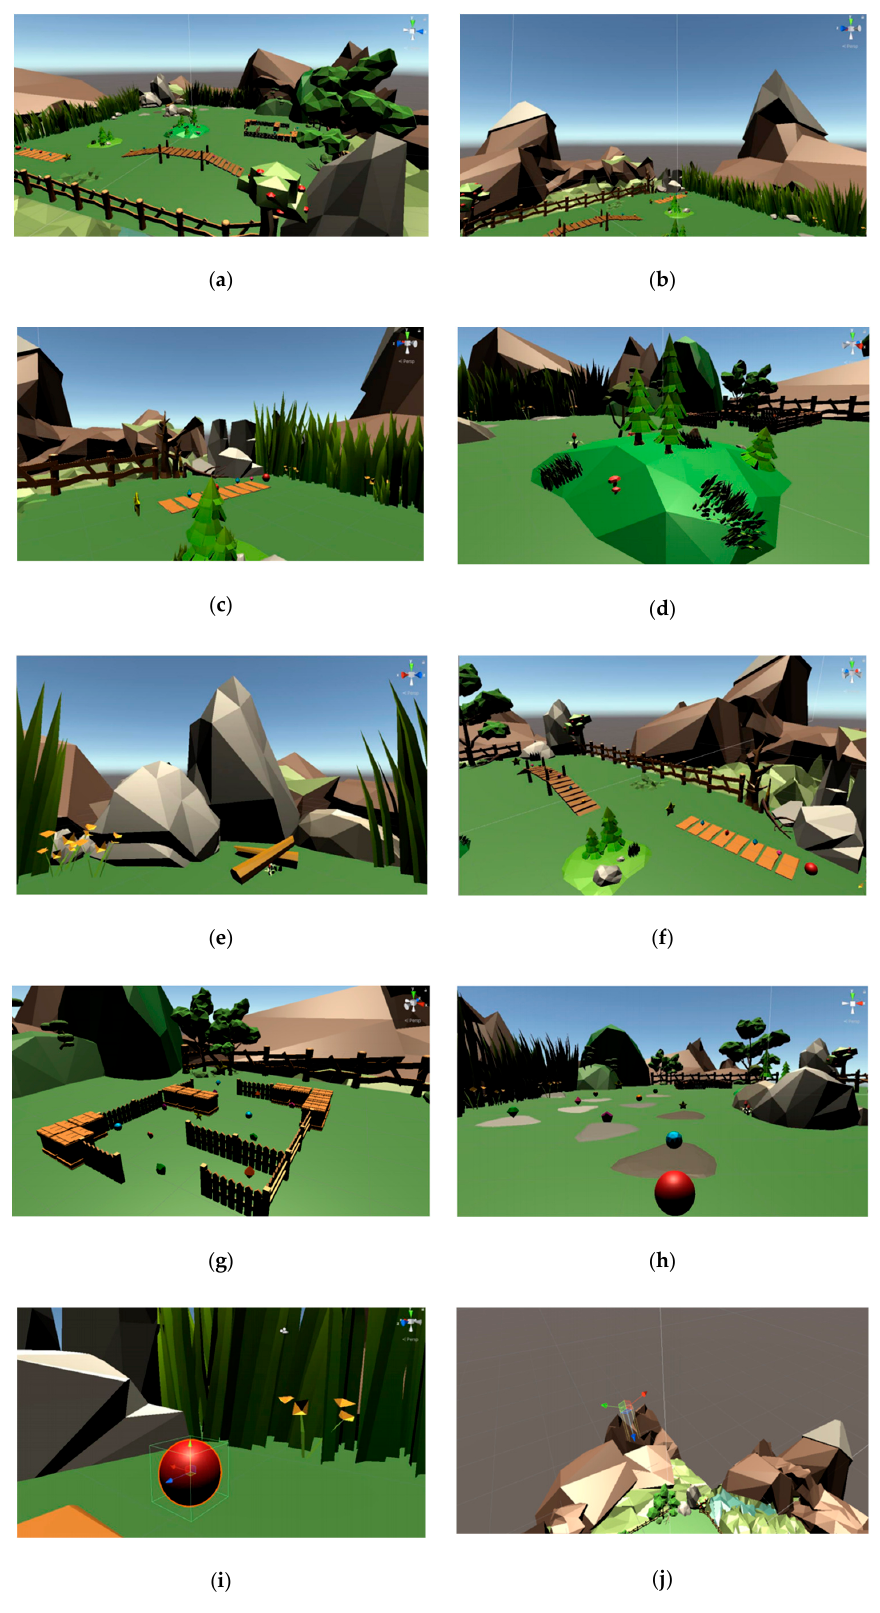
Figure 2. Game views: ( a ) view of the board; ( b ) view of the mountains; ( c ) view of the fence; ( d ) view of the vegetation; ( e ) view of the boulders; ( f ) the first two levels; ( g ) the third level of the game; ( h ) the fourth level of the game; ( i ) player object; ( j ) light in the